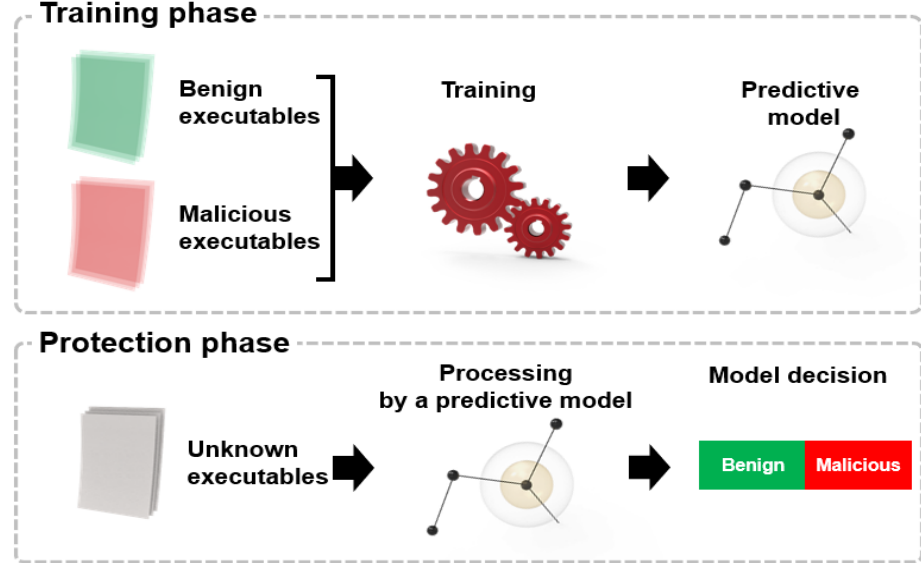
Figure 3. ML: detection algorithm life cycle.